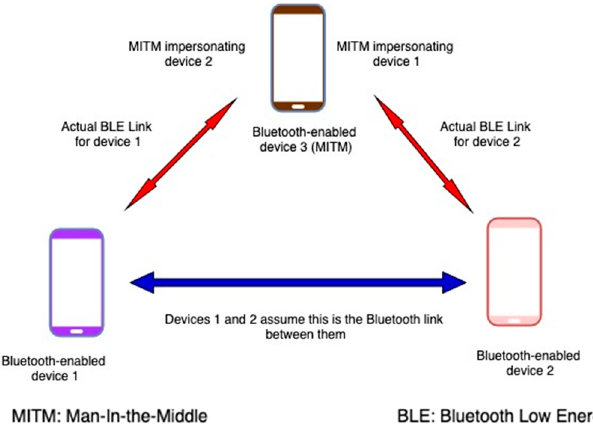
Figure 11. Man-in-the-Middle (MITM) attack on Bluetooth.